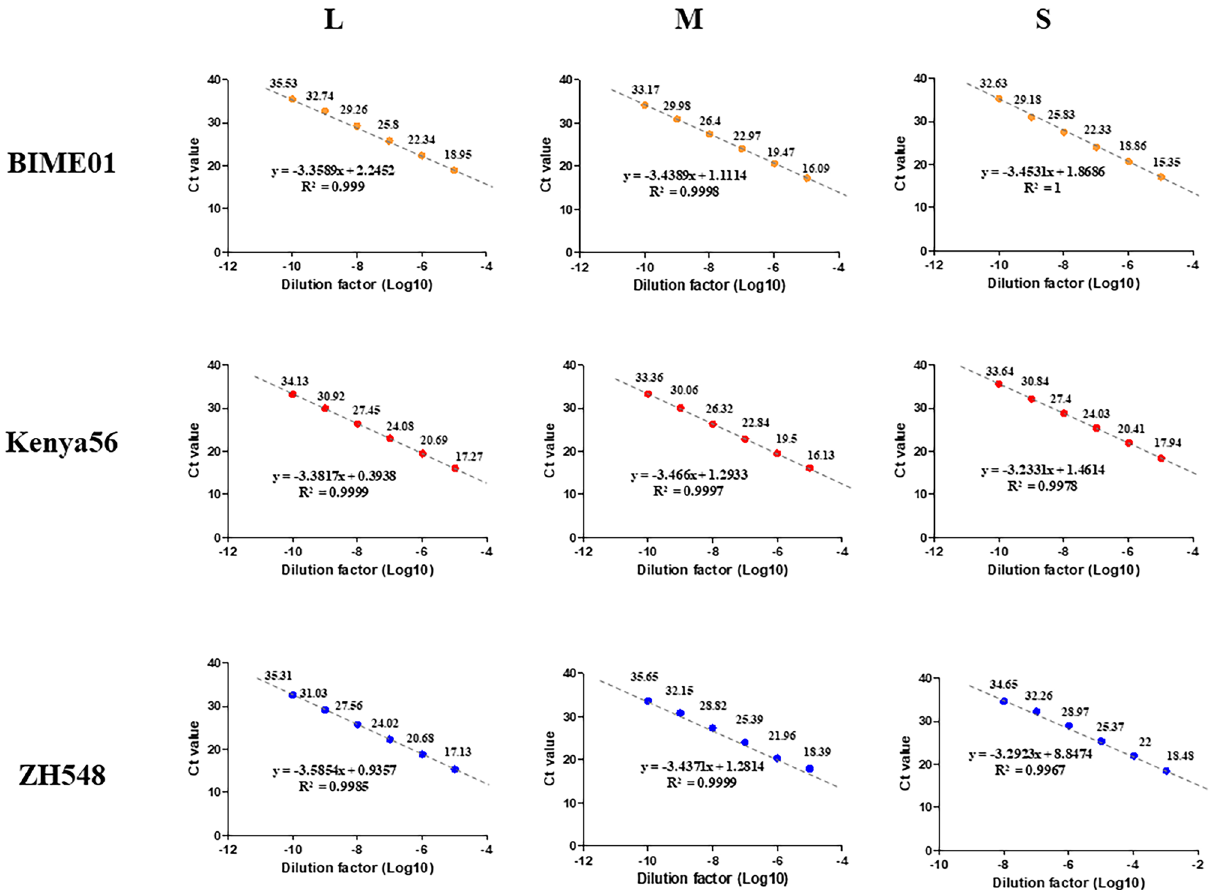
Figure 1. The Ct value results of the RT-qPCR. The colors orange, red, and blue indicate the BIME01, Kenya56, and ZH548 strain of the Rift valley fever virus, respectively. Each strain contains the L, M, and S segments. The number above the dot indicates the mean Ct